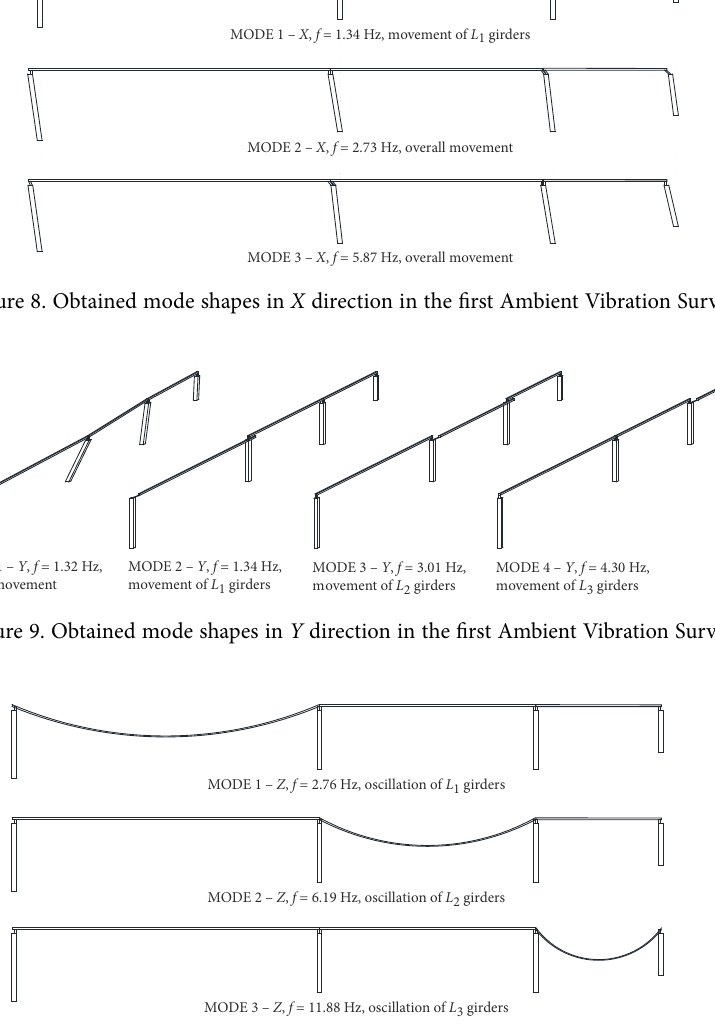
Figure 10. Obtained mode shapes in Z direction in the first Ambient Vibration